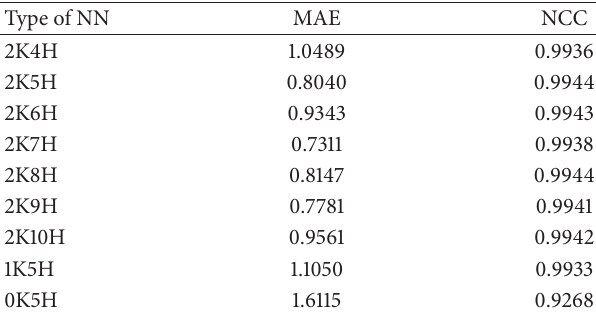
Table 2: Error in different hidden and knowledge neurons of tapered dual-plane EBG.